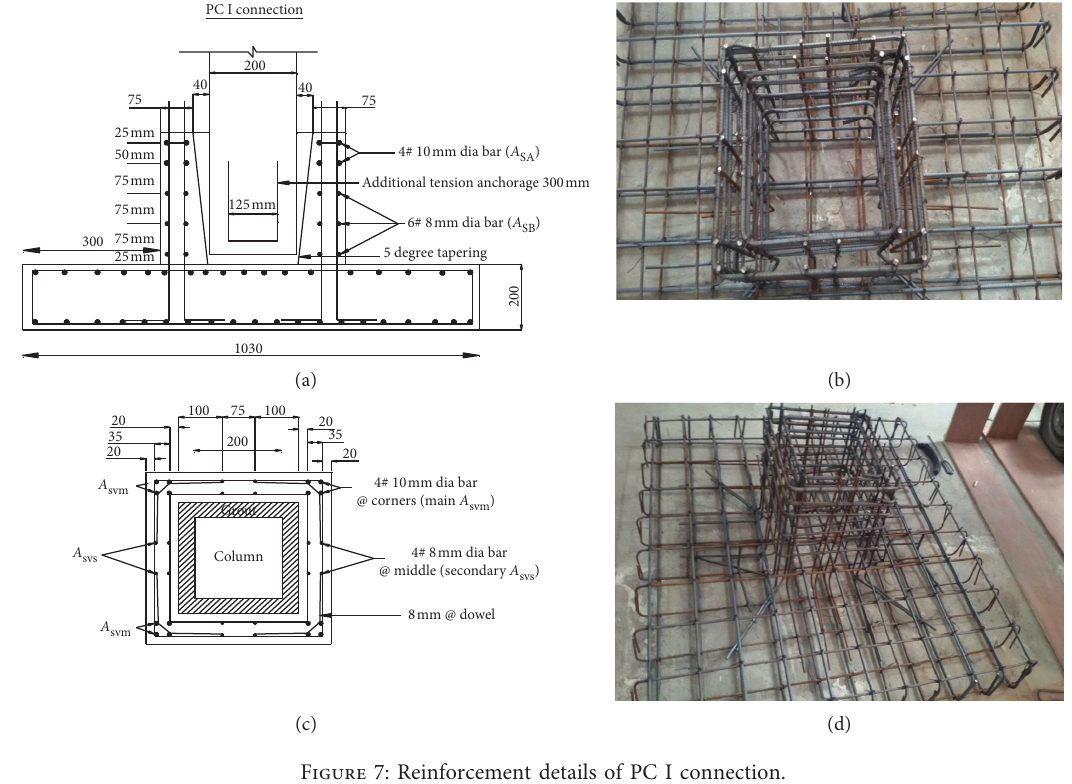
Figure 7: Reinforcement details of PC I connection.